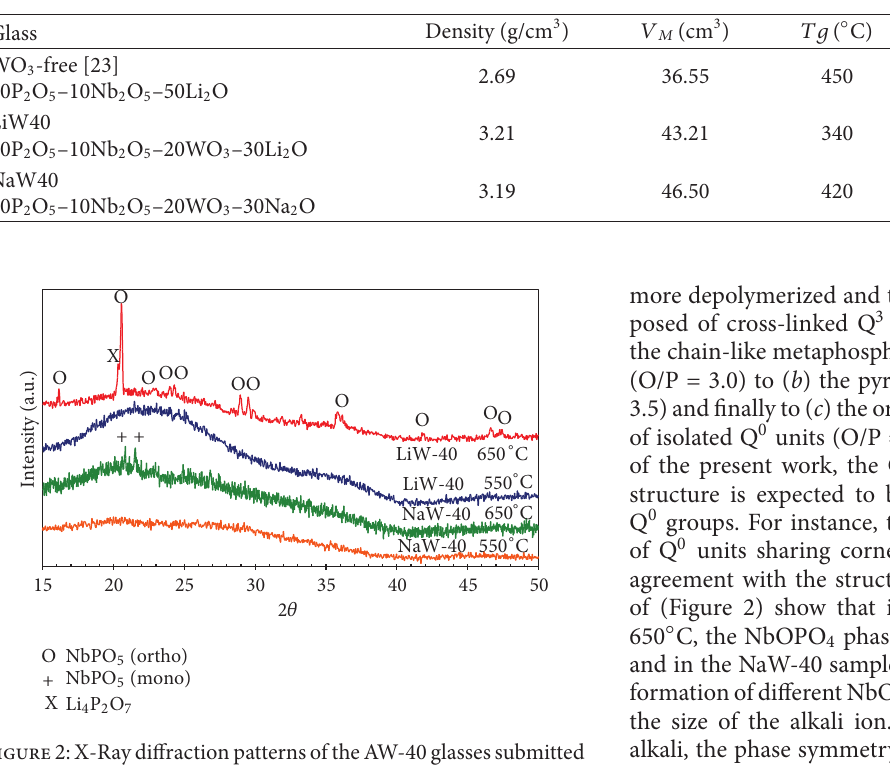
T 1: Physical parameters for AW-40 glasses.